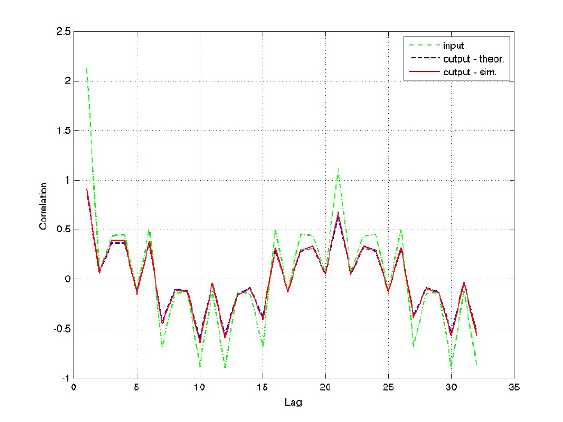
Figure 5. Line enhancer output signal autocorrelation.